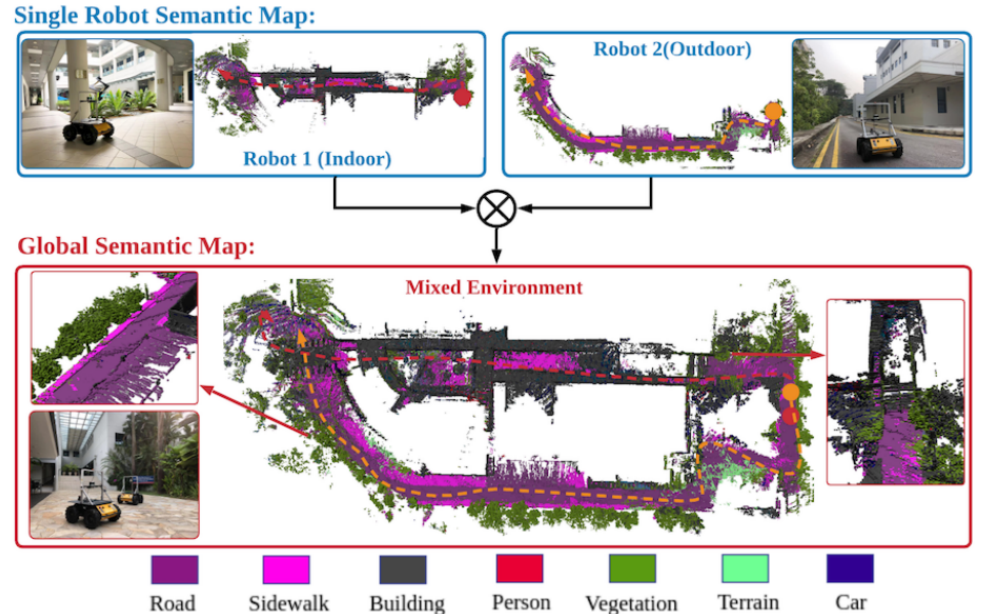
Figure 8. An example of collaborative semantic mapping in mixed indoor–outdoor environment. Red trajectory is robot 1, and orange trajectory is robot 2. Top: local semantic maps generated by two robots. Bottom: collaboratively generated global semantic map